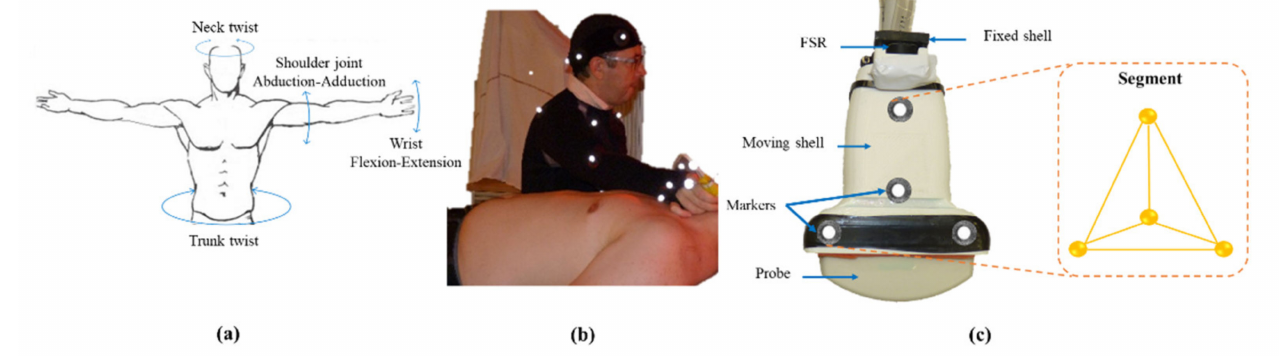
Figure 1. Study of the angiologist’s gestures using MoCap: ( a ) Measured angles on the angiologist’s body. ( b ) Reflective markers fixed to the angiologist’s body ( c ) Reflective markers and FSR sensor fixed to the probe.